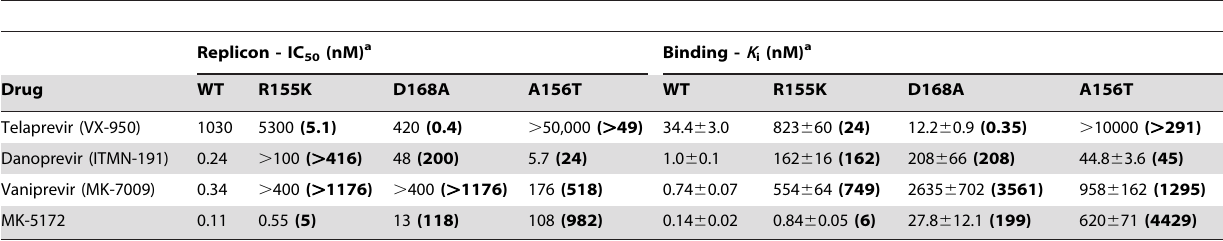
Table 1. Drug susceptibilities against wild-type and resistant HCV clones and inhibitory activities against NS3/4A proteases.